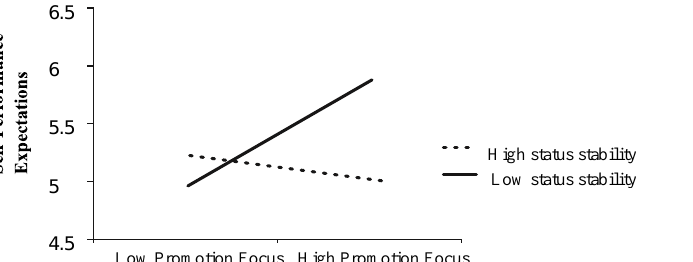
Figure 2: The relationships between self-performance expectations and status stability in predicting Promotion focus